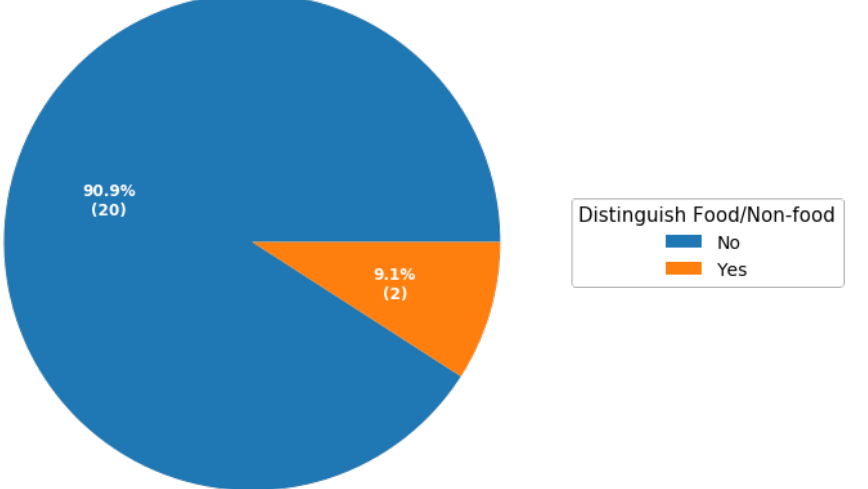
Figure 5. Percentages of mobile computer vision-based studies for food recognition and volume estimation that distinguish between food and non-food. The number of computer vision-based applications that distinguish food and non-food from studies survey is shown in brackets.